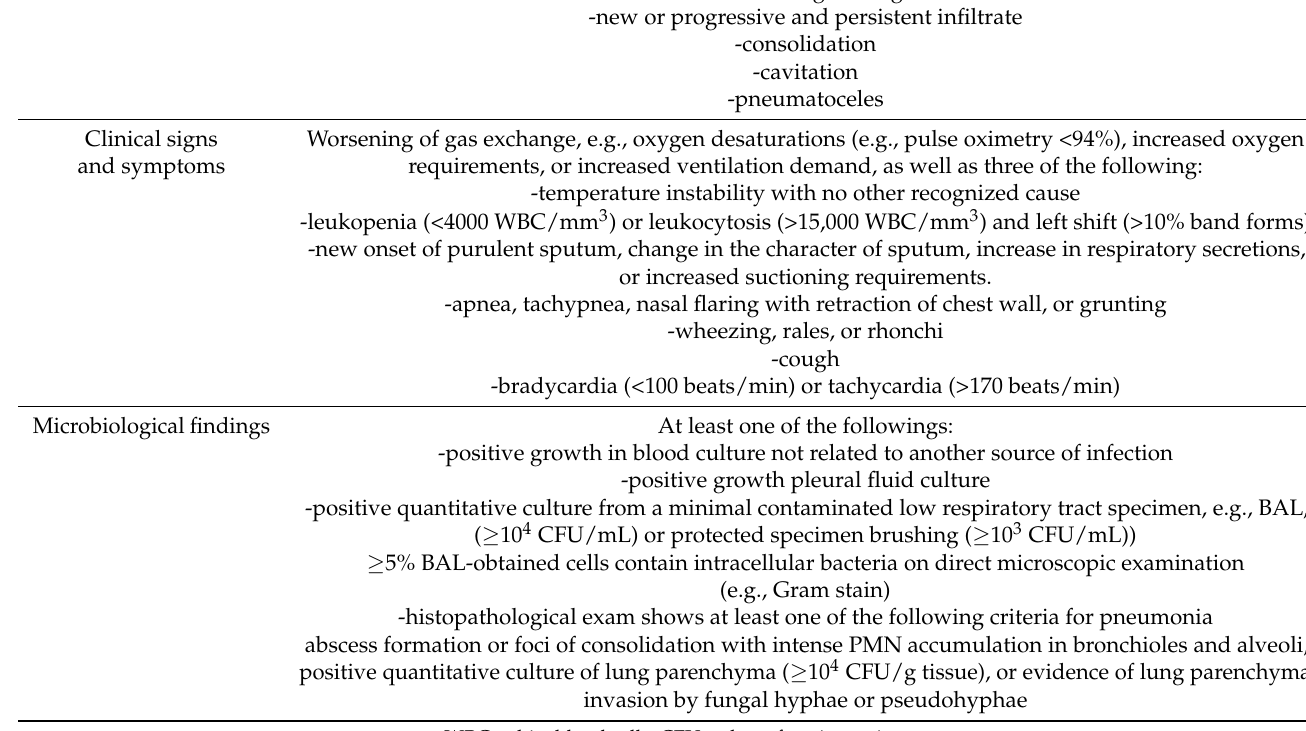
Table A1. Diagnostic criteria for neonatal ventilator-associated pneumonia in this study, based on the CDC criteria [43]. Radiological